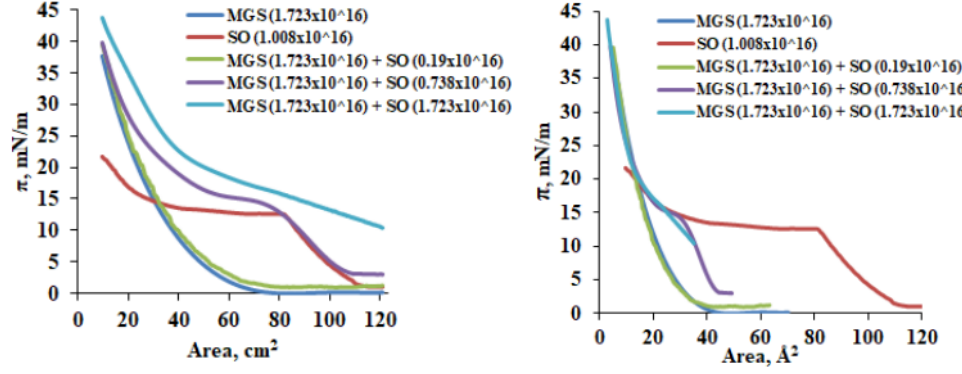
Figure 4. Surface pressure ( π )/area (A) isotherms of MGS/SO pseudobinary films presented in terms of total film area (cm 2 ; Left panel ) and apparent area per molecule (Å 2 ; Right panel ). The numbers in brackets denote the total number of MGS and SO molecules deposited at the trough surface. For the interpretation of the values of area per molecule for meibum containing films please refer to the main text. Here MGS content is kept constant and the total lipid amount is increased by supplementation with SO. This regime is similar to the effect of SO delivery via eye drops at the ocular surface (see main text or